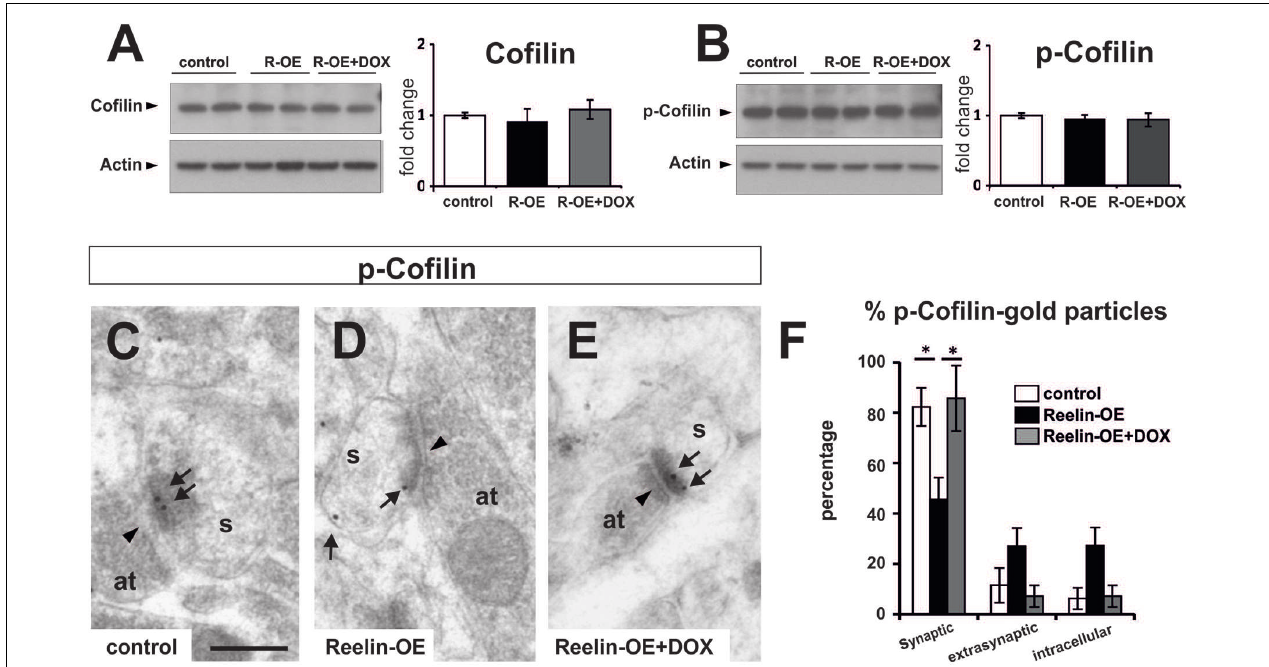
FIGURE 5 | Expression of Cofilin and p-Cofilin in Reelin-OE mice. (A) Left, immunoblot analysis of Cofilin in control, Reelin-OE, and DOX-treated Reelin-OE mice. Right, histogram showing densitometric analysis ( n = 3 animals per group) by fold change in the three groups of mice (mean ± SEM; ANOVA test). (B) Left, immunoblot analysis of p-Cofilin in control, Reelin-OE, and DOX-treated Reelin-OE mice. Right, histogram showing densitometric analysis ( n = 3 animals per group) by fold change in the three groups of mice (mean ± SEM; ANOVA test). (C–E) Examples of immunogold labeling against p-Cofilin in dendritic spines (s) receiving a synaptic contact from an axon terminal (at) in the SR of control (C) , Reelin-OE (D) , and DOX-treated Reelin-OE (E) mice. Note synaptic contacts indicated by arrowheads and immunolabeling dots by arrows. Scale bar, 250nm. (F) Histogram illustrating the proportion of dots in the synaptic contact, the extrasynaptic membrane and the intracellular domain of dendritic spines in the SR of Reelin-OE and DOX-treated Reelin-OE mice and their control littermates (mean ± SEM; ∗ p < 0.05; ANOVA test).